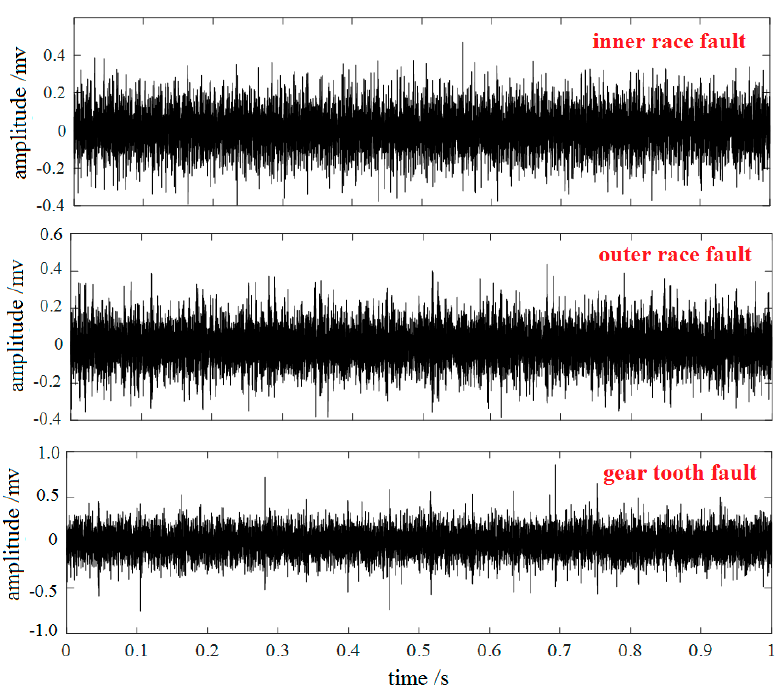
Figure 6. Vibration signals collected under different drive train faulty conditions.